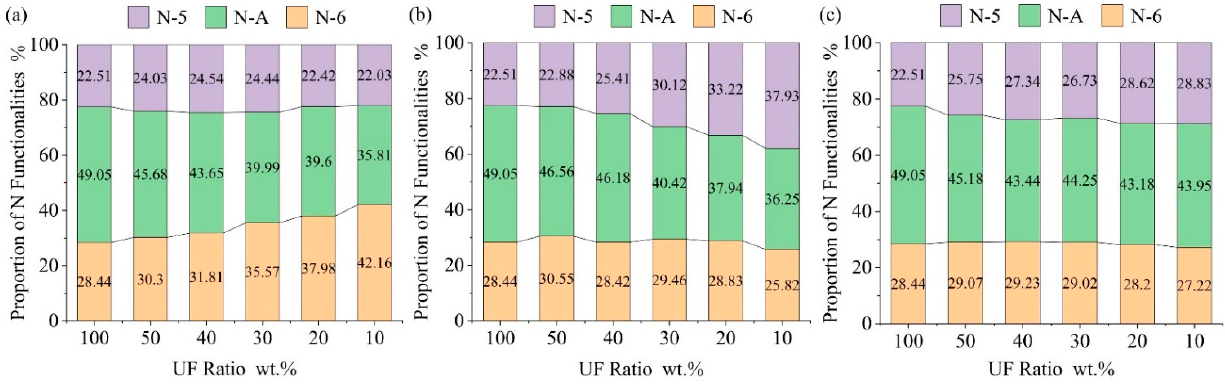
Figure 5. Distribution of N functionalities in model compounds-UF chars: ( a ) N functionalities in Ethyl maltol-UF chars; ( b ) N functionalities in DMHF -UF chars; ( c ) N functionalities in Glucose-UF chars.